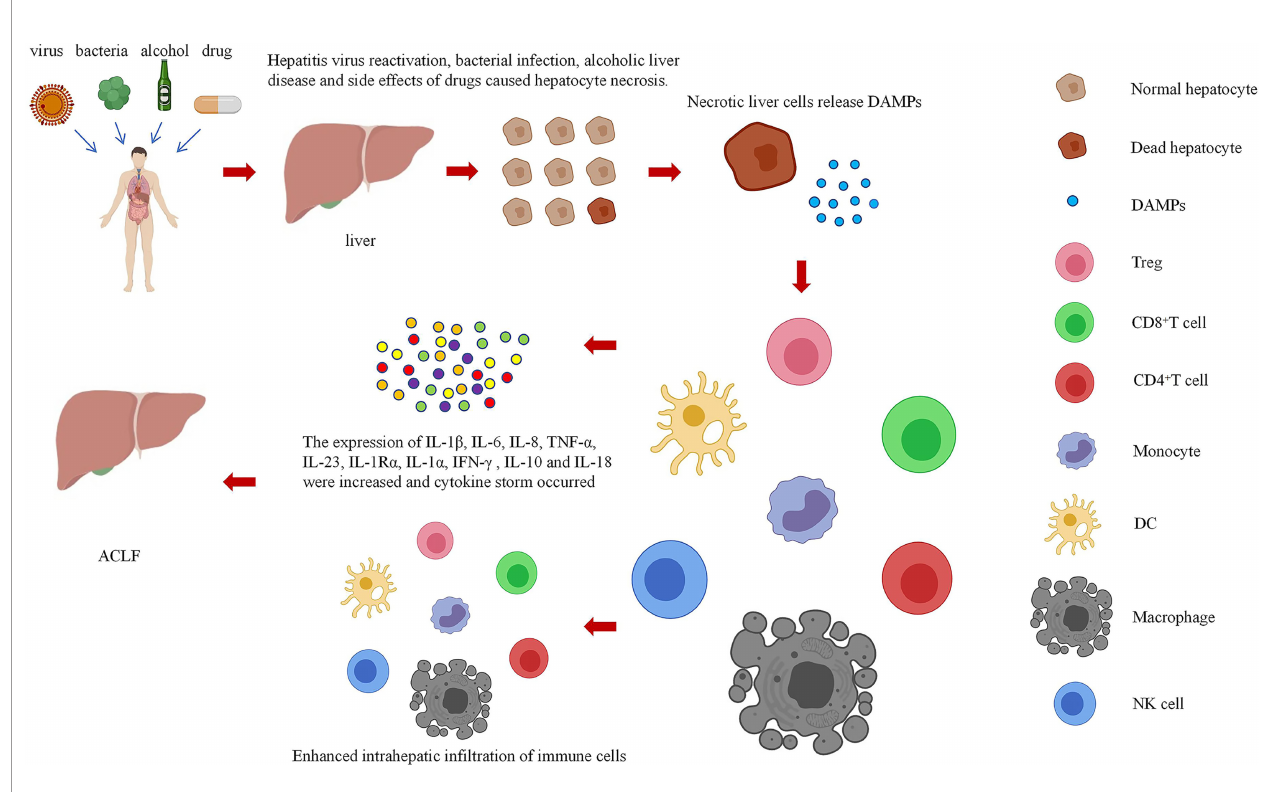
FIGURE 2 | Relationships among cell necrosis, DAMPs, and